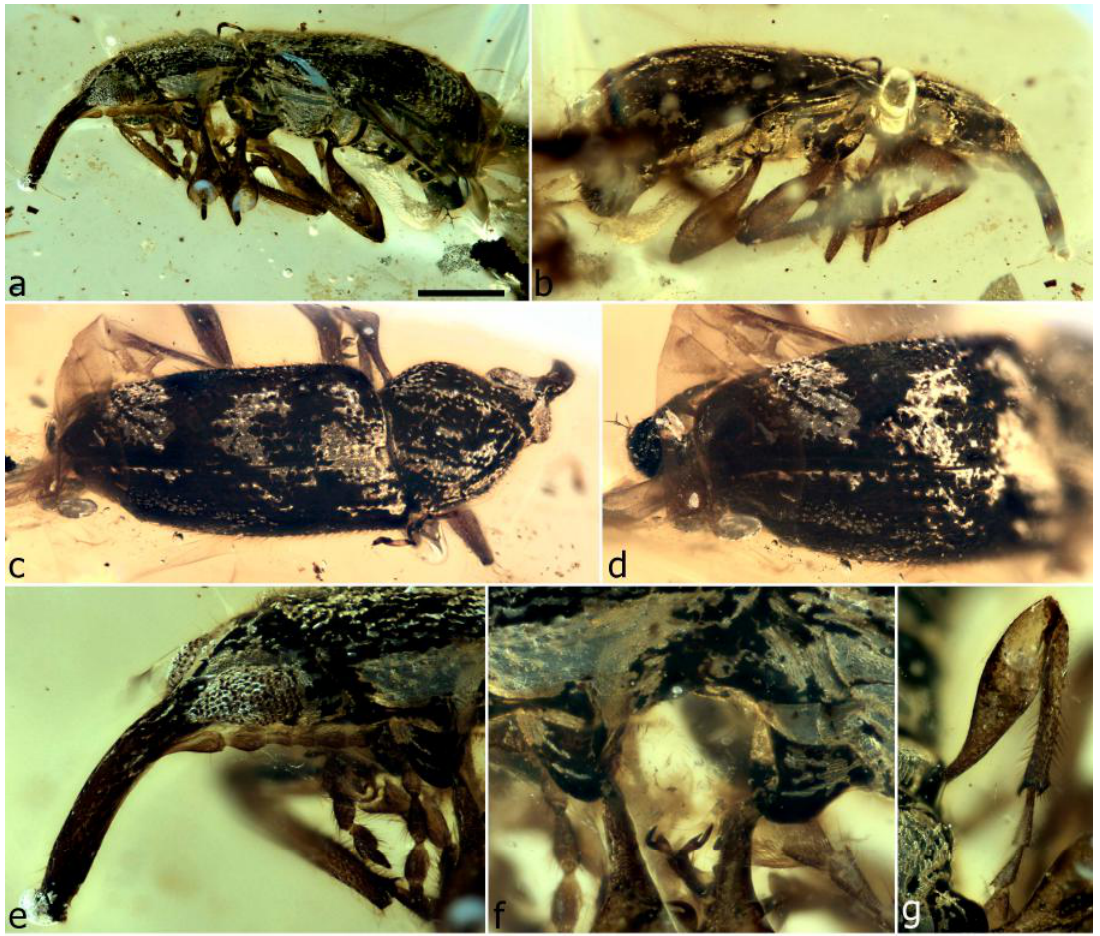
Figure 25. Acalyptopygus brevicornis sp. n., holotype. Habitus, left lateral ( a ); right lateral ( b ); dorsal ( c ); elytral apices and pygidium, dorsal ( d ); head and prothorax, showing median costa of forehead ( e ); pro- and mesocoxae, showing closed coxal cavities ( f ); left metatibia ( g ). Scale bars: 0.5 mm (a). Acalyptopygus lingziae Clarke & Oberprieler, sp. n. (Figure 26) Description . Size. Length 2.75 mm, width 1.1 mm. Eyes only slightly slanting backwards,